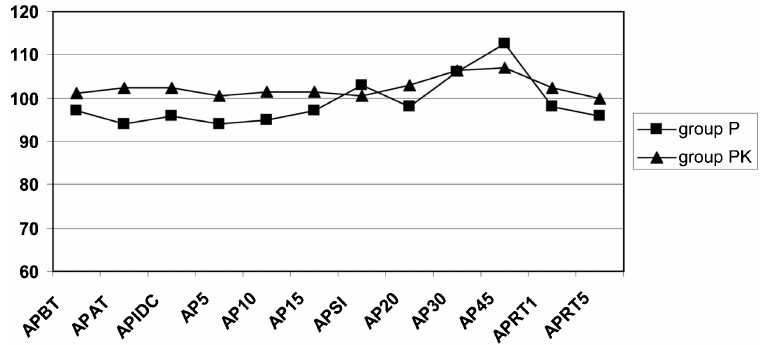
Figure 2 - Variation of average blood pressures relative to time. APBT: Average blood pressure Before tourniquet, APAT: After tourniquet, APIDC: Inflation of the distal cuff, APSI: Surgical incision, APRT1: First minute after the release of the tourniquet, APRT5: Fifth minute after the release of the